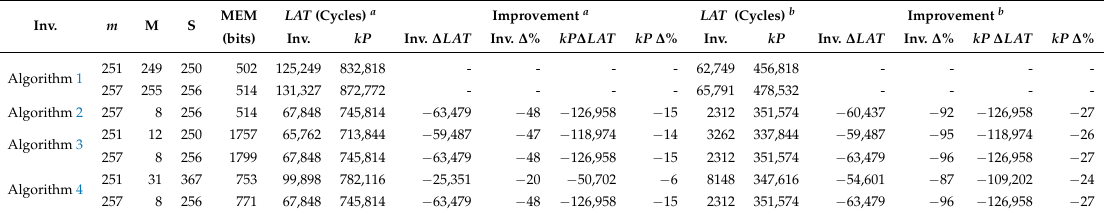
Table 2. Latency costs for inversion algorithms and kP over binary fields of approximately 128-bit security. We evaluate m = 251 which corresponds with the curve used (BE251) and m = 257 which has the form m = 2 8 + 1 to showcase the best and the average complexities for Itoh-Tsujii inversions. Inv.